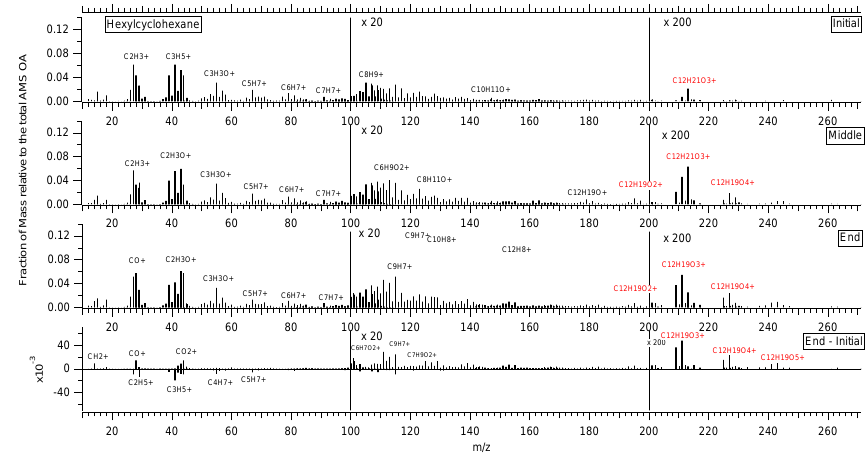
Fig. 6. High-resolution mass spectrum of SOA formed from hexylcyclohexane at initial organic growth, mid-experiment, and end of exper- iment. The difference spectrum is also shown. m/z 101–200 are multiplied by 20, and m/z 201–300 are multiplied by 200 for visual clarity. Ions with high signal are labeled. Ion labels in red correspond with proposed ion assignments in Table 6.